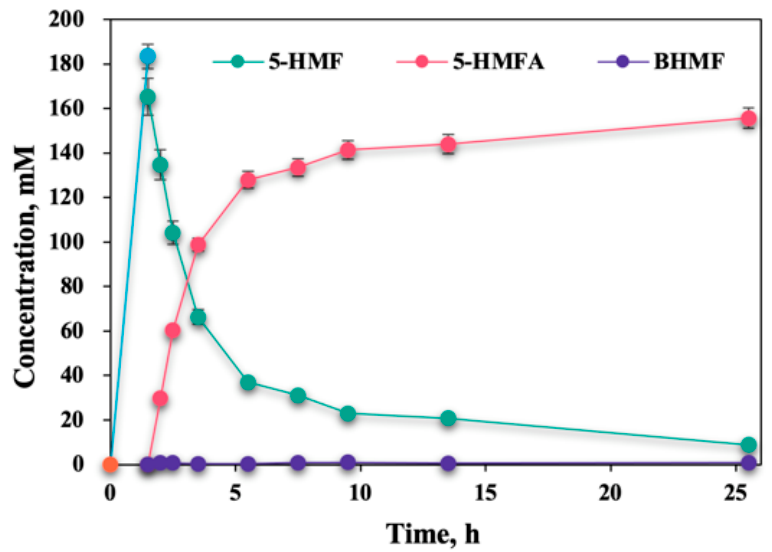
Figure 8. Time courses for chemoenzymatic transformation of D -fructose into 5-HMFA. A mass balance was calculated from D -fructose to 5-HMFA in a B:Gly–water system (Figure 9). D -fructose (1.8 kg) was dehydrated with SG(SiO 2 ) (1.5 kg) and DESs B:Gly (10 kg) under a temperature of 150 ◦ C for 90 min. The resulting 5-HMF liquid containing 1.16 kg of 5-HMF was adjusted to pH 7.5 and then added to E. coli AT (2.77 kg) and D -Ala (12.25 kg) for biological amination at 35 ◦ C, achieving the productivity of 0.61 kg 5-HMFA/kg substrate D -fructose at pH 7.5 in 1 d. Coupling of a biocompatible non- enzymatic catalyst and a highly selective enzymatic catalyst to carry out the dehydration of D -fructose into 5-HMFA in B:Gly–water was feasible, which would diminish equipment input, and avoid the separation of intermediates.